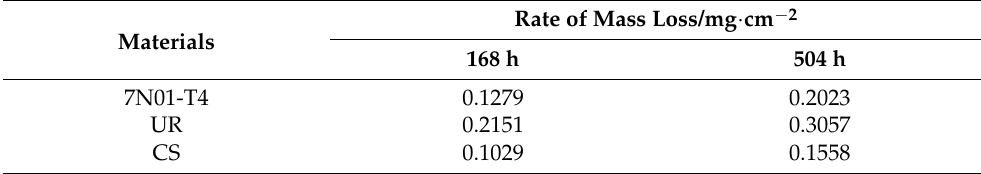
Table 3. The rates of mass loss after the alternate immersion